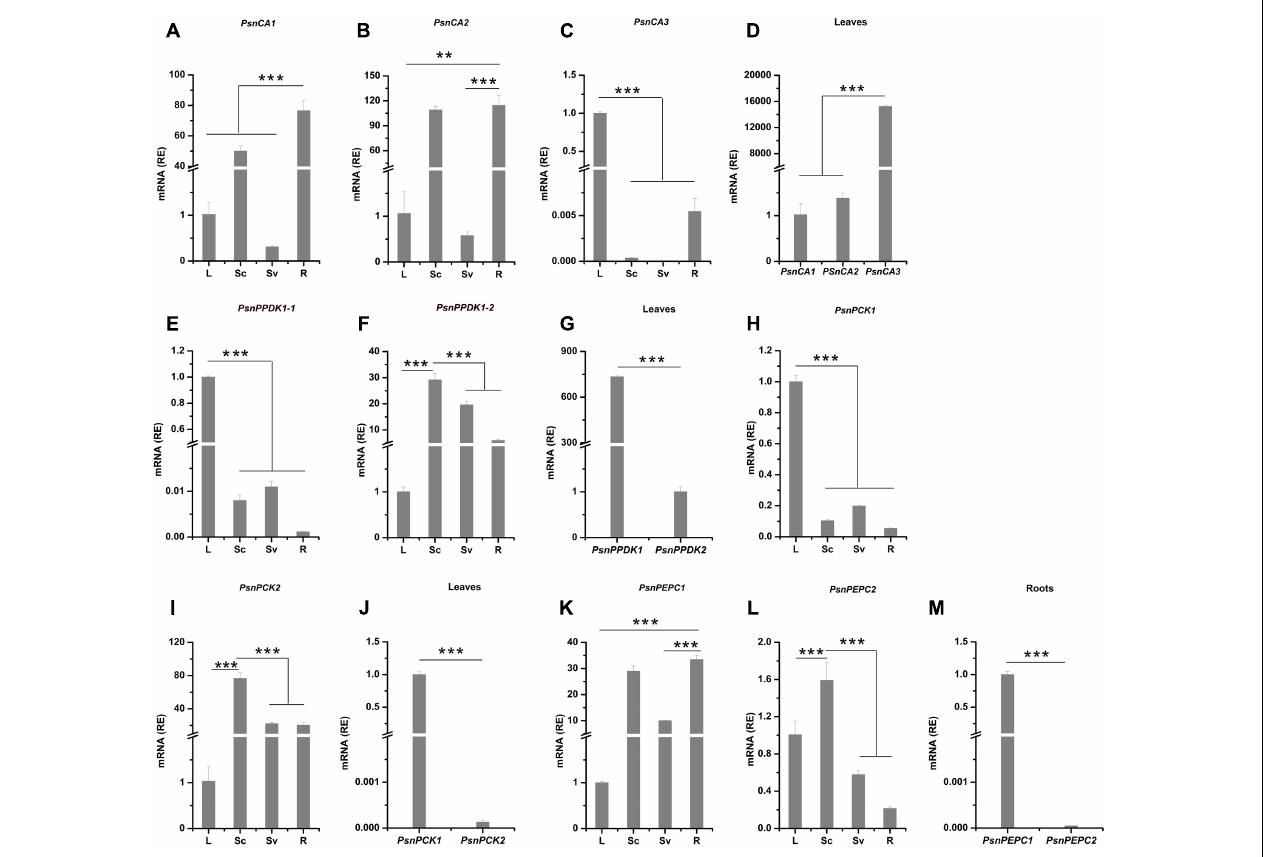
FIGURE 2 | The relative expression levels of poplar genes homologous to C 4 photosynthetic enzyme genes in different tissues of poplar. (A–M) All tissues were harvested from 5-month-old poplar plants grown in a greenhouse 4 h after the onset of illumination. The expression levels of PsnCA genes (A–D) , PsnPPDK genes (E–G) , PsnPCK genes (H–J) and PsnPEPC genes (K–M) genes. Expression levels were normalized to PsnACTIN2 expression. All relative enrichment (RE) values are means of at least three independent experiments. Bars indicate SE. Leaves (L), stem chlorenchyma (Sc), stem vascular tissue (Sv), and roots (R). Asterisks indicated significantly different means ( ∗∗∗ p < 0.001) as determined with a t